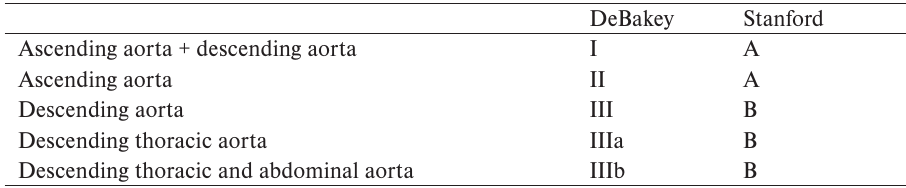
Table 1. Classification of aortic dissection by DeBakey and Stanford.